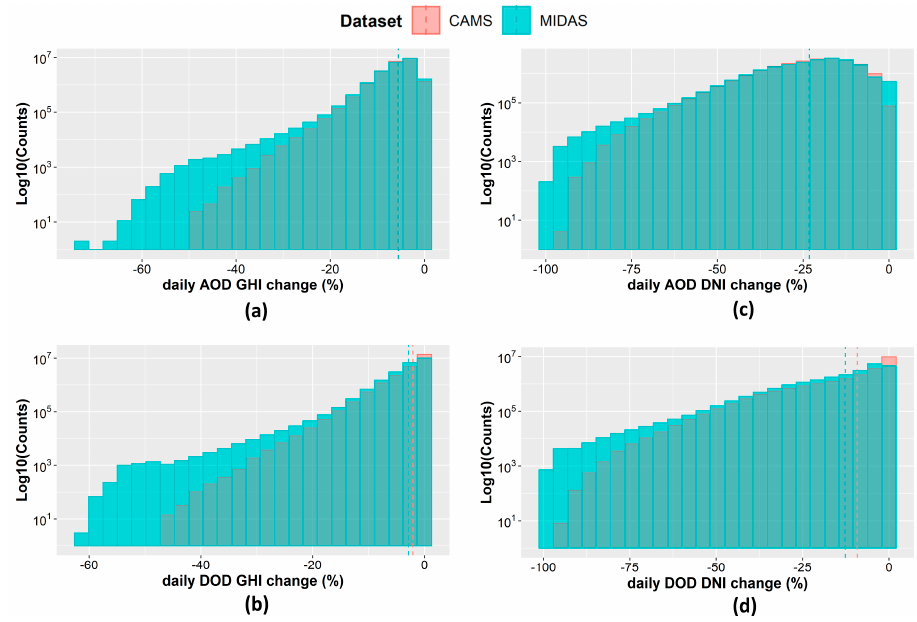
Figure 10. Distribution of daily GHI change (%) due to the presence of aerosols ( a ) and dust ( b ) under MIDAS and CAMS AOD and DOD. The same for daily DNI change (%) in panels ( c , d ). The intercomparison between MIDAS and CAMS AOD and DOD effects on